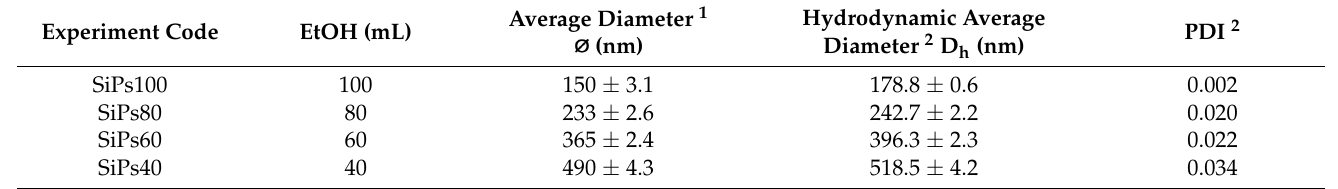
Table 1. Impact of the different amounts of EtOH used for the synthesis of SiPs on the diameter.